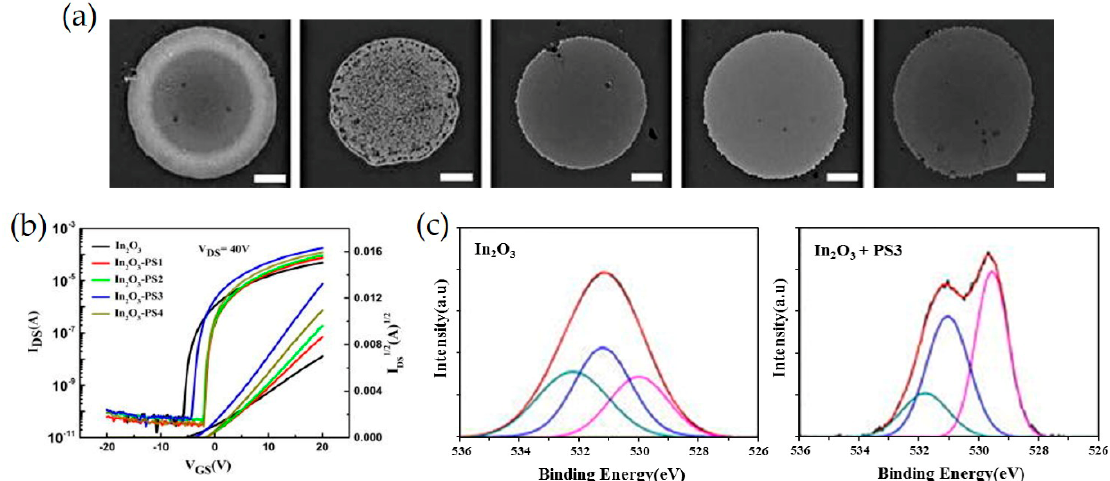
Figure 6. ( a ) Optical microscopy images of In 2 O 3 deposition (right to left) without PS, with PS1, with PS2, with PS3, and with PS4. The scale bar is 100 µ m. ( b ) Transfer characteristics of inkjet-printed